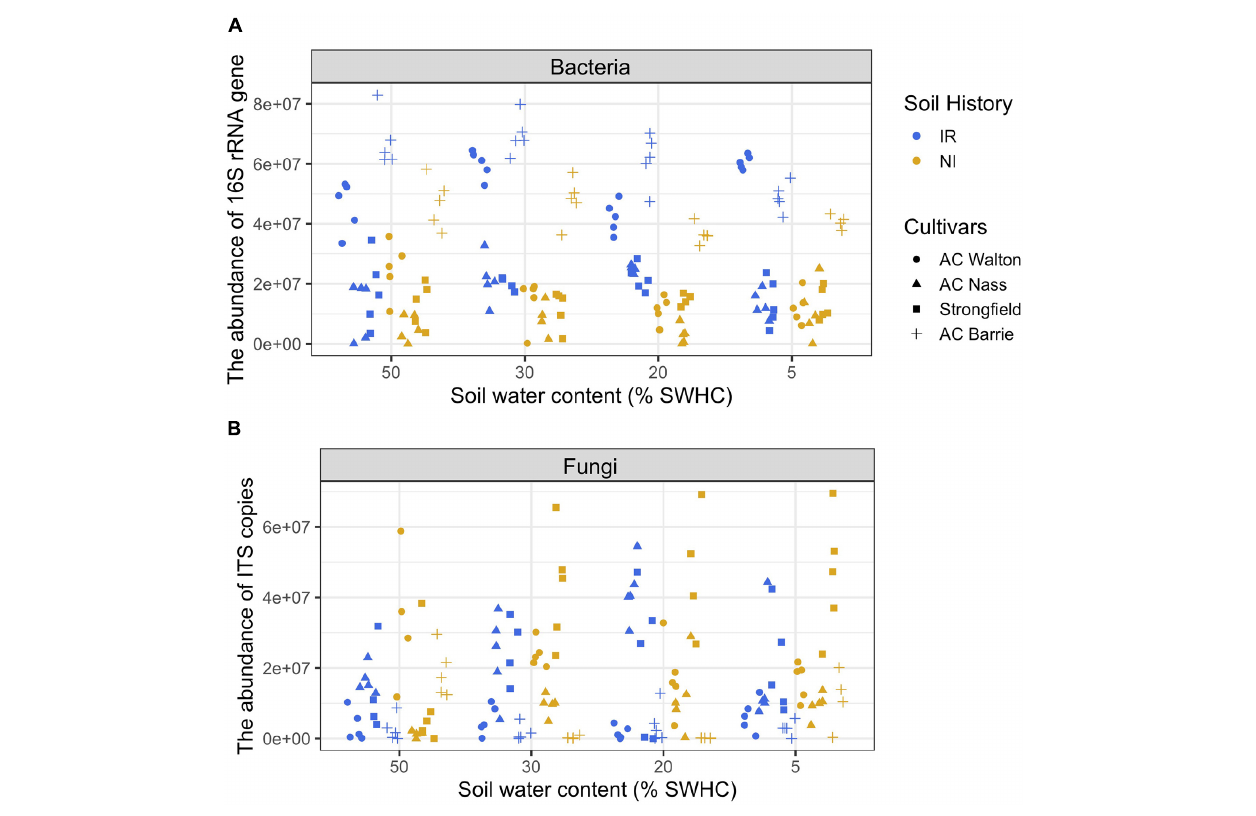
FIGURE 1 | The abundance of (A) bacterial 16S rRNA gene (copies g - 1 soil dry weight) and (B) fungal ITS region (copies g - 1 soil dry weight) in the rhizosphere of four wheat genotypes grown in soil with two contrasting stress histories (Soil history) under different contemporary water stress (SWHC).